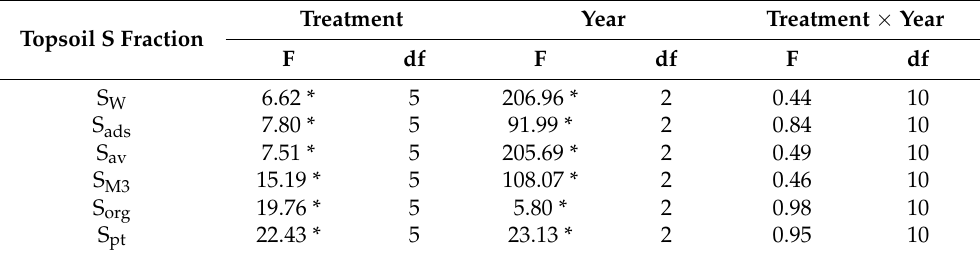
Table 8. Results for two-way ANOVA comparing the effects of treatment, year, and their interaction on the S content in individual S fractions in topsoil. Topsoil S Fraction